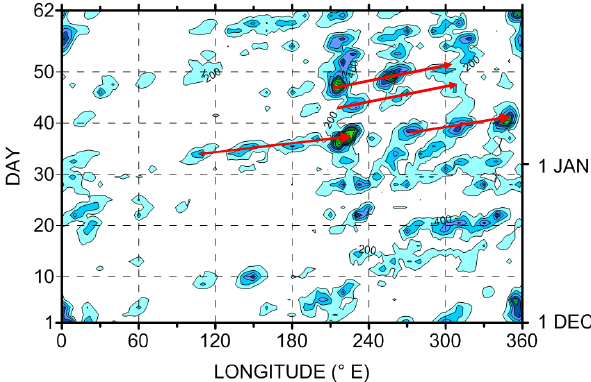
Fig. 8. Hovm¨oller diagram of the squared velocity of meridional wind (m 2 s − 2 ) from 1 December 2002 until 31 January 2003 aver- aged over a latitudinal belt (30 ◦ –50 ◦ N) at 300hPa. Contours are Figure 8: Hovmöller diagram of the squared velocity of meridional wind (m 2 s -2 ) from 1 smoothed with a Gaussian filter and start at 200m 2 s − 2 with an in- December 2002 until 31 January 2003 averaged over a latitudinal belt (30°-50° N) at 300 hPa. terval of 200m 2 s − 2 . Arrows indicate direction of group velocity of four revealed Rossby-wave Contours are smoothed with a Gaussian filter and start at 200 m 2 s -2 with an interval of 200 m 2 s -2 . Arrows indicate direction of group velocity of two revealed Rossby-wave trains.